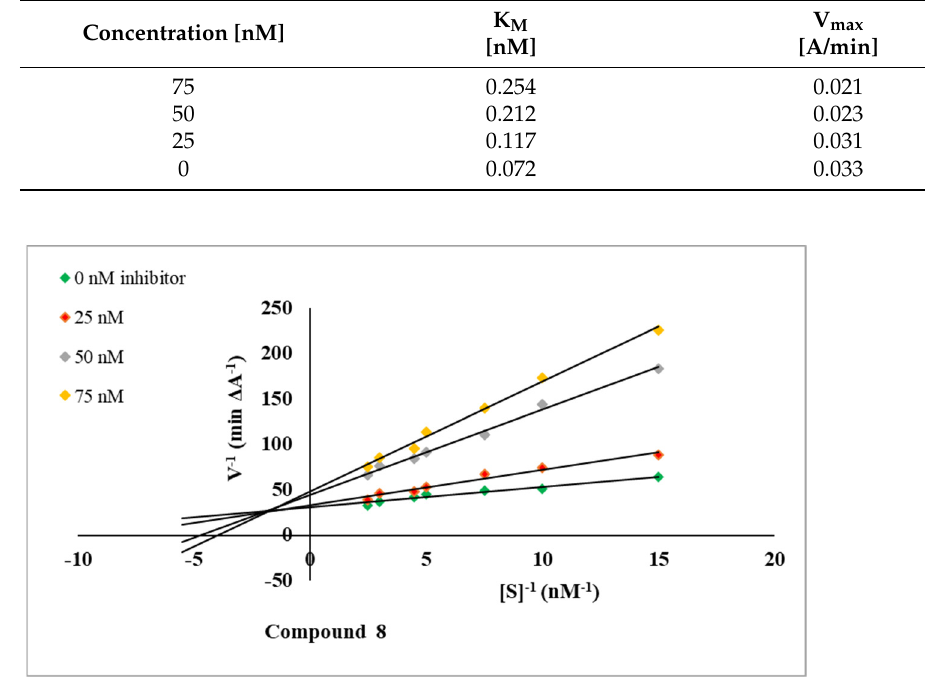
Table 2. The K M and V max values at different compound 8 concentrations in relation to AChE.